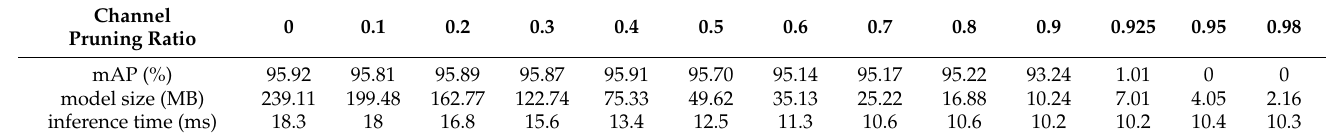
Table 3. Evaluation results of the channel pruning model.